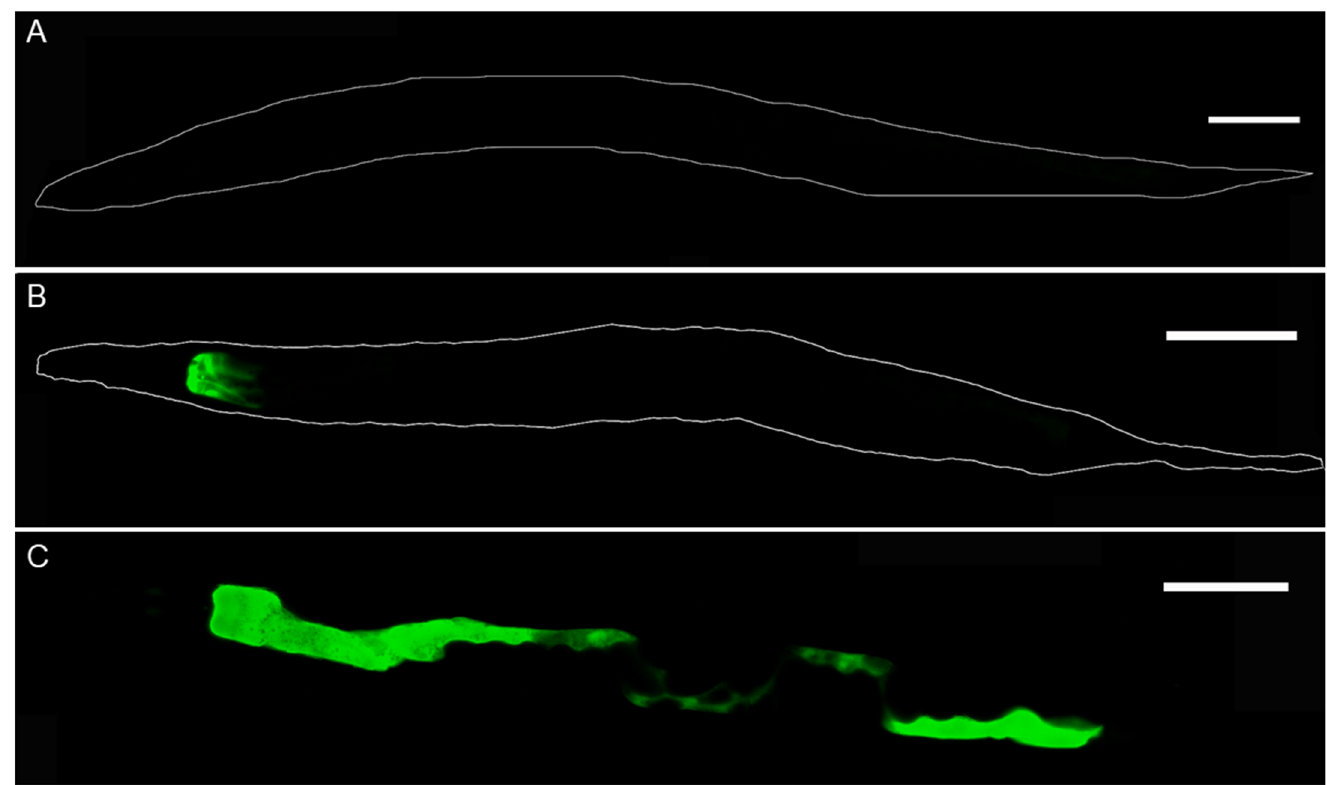
Fig 3. Representative images of C . elegans expressing pT22D1.2::GFP depending on treatment with hydroethanolic extract from C . mucronatum . A: negative control (DMSO 1%); B: treatment with 0.2 mg/mL extract; C: treatment with 2 mg/mL extract. Scale bars = 100 μ m.